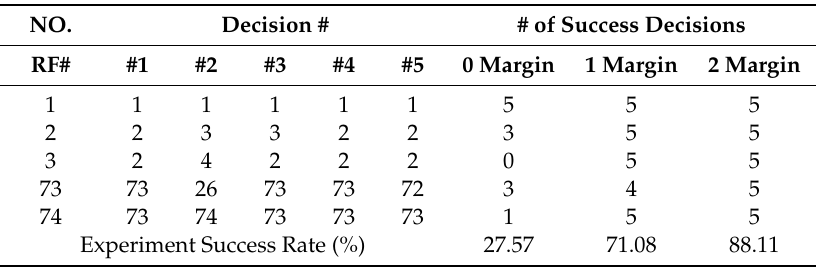
Table 5. Example of experimental results.